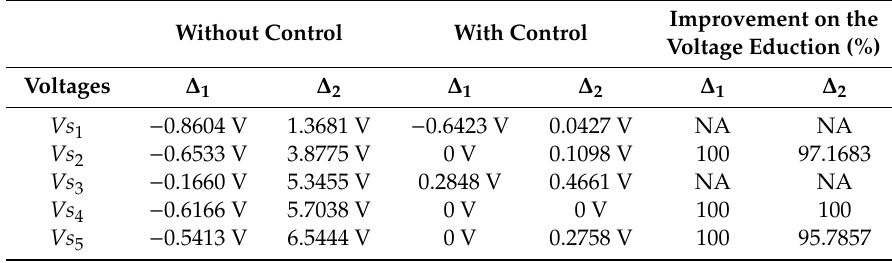
Table 4. Voltage gradients of the µ G. Without Control With Control